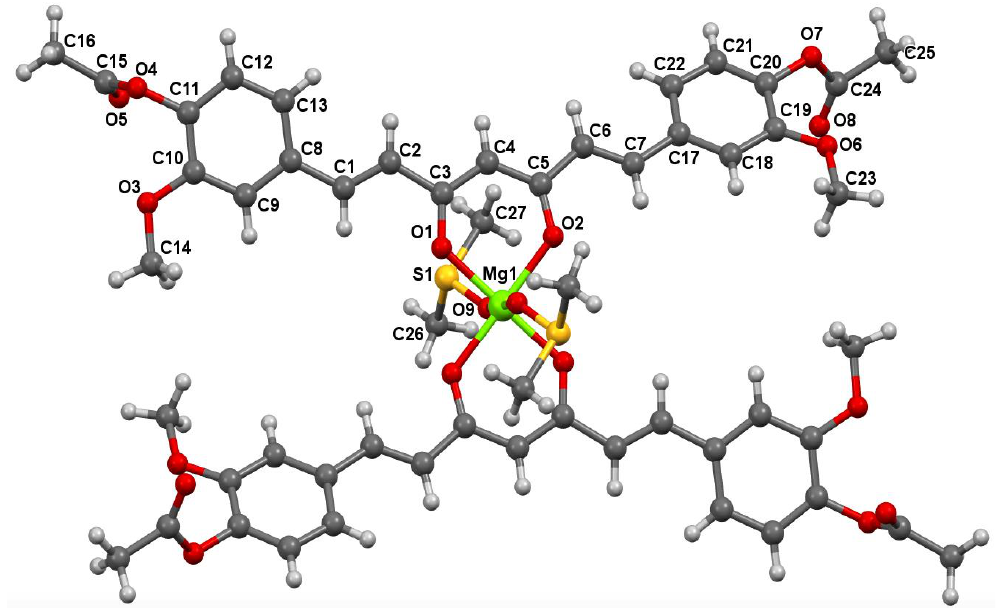
Figure 2. Molecular structure of 2 . Hydrogen atoms are drawn as circles with an arbitrary radius.